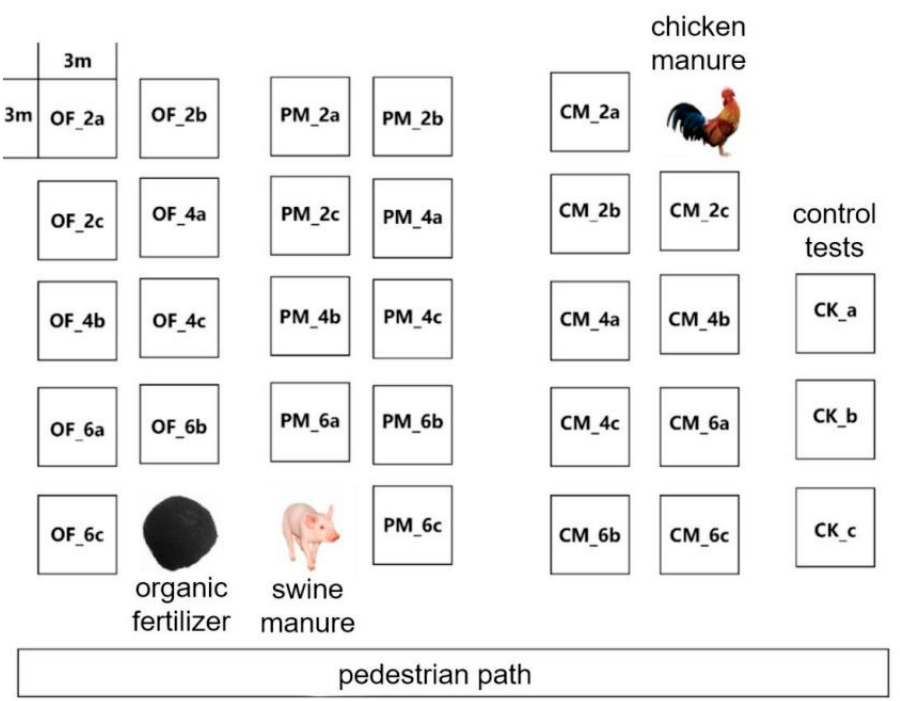
Figure 1. The experimental site layout (CK: control; CM: chicken manure; OF: organic fertilizer; SM: swine manure;PM represents swine manure).